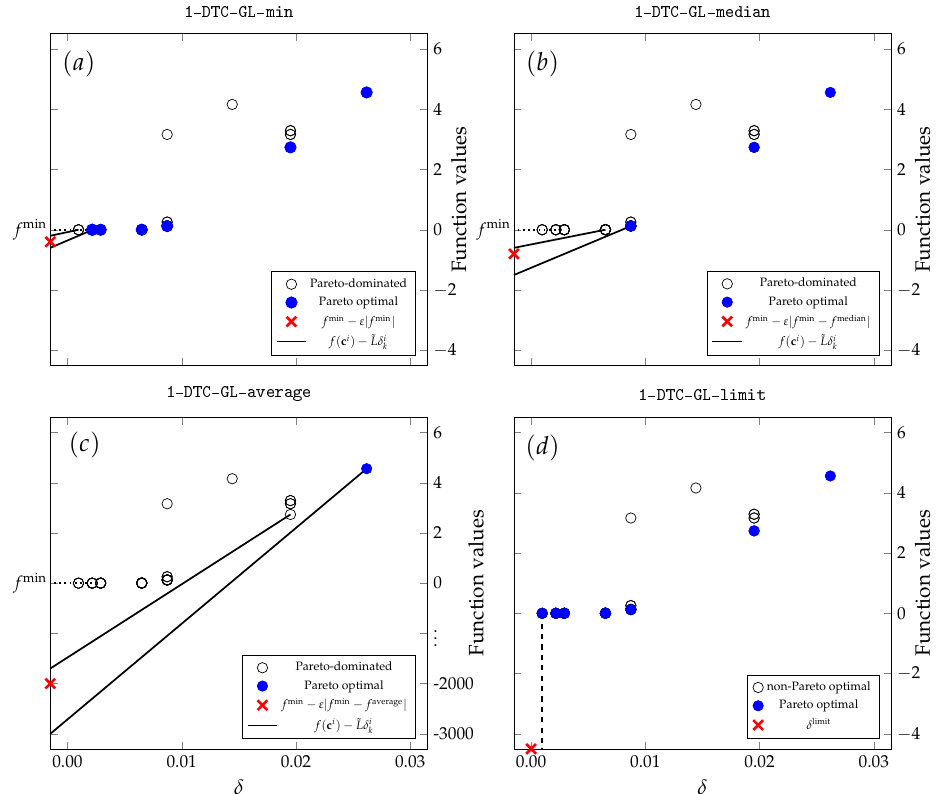
Figure 3. Comparison of two-step Pareto selection using four excessive local refinement reduction techniques implemented to 1-DTC-GL . All four graphs illustrate the selection in the thirteenth iteration of the two-dimensional Csendes test problem with ε = 10 − 4 . The selected hyper-rectangles using 1-DTC-GL-min are shown in part ( a ), 1-DTC-GL-median in part ( b ), 1-DTC-GL-average in part ( c ), and 1-DTC-GL-limit in part ( d ). For clarity, only small diameter hyper-rectangles are shown, as all excessive refinement reduction techniques have no impact on larger